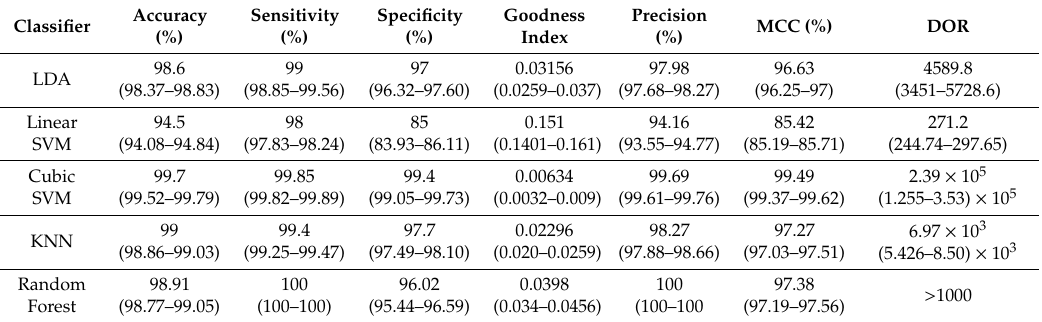
Table 4. Evaluation metrics (with their 95% confidence intervals) for evaluating stress levels using Feature-Set 3.